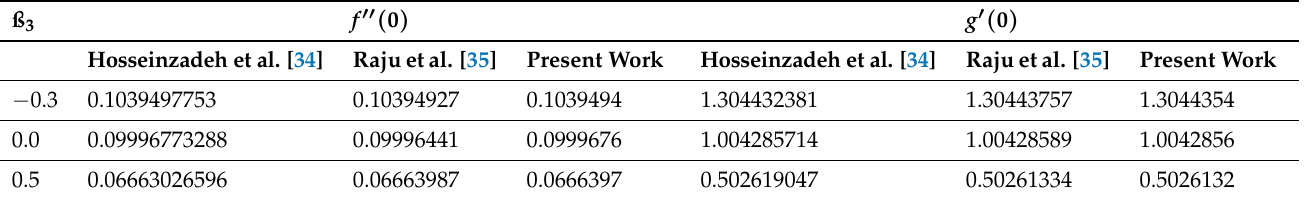
Table 3. Validation the current solution with previous published data when γ 1 = γ 2 = M = φ = ß 1 = ß = λ 1 = 0 and Re r =